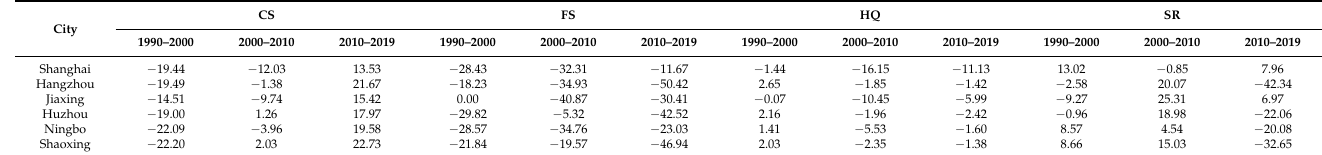
Table 5. Change rates of ESs in SHB from 1990 to 2019